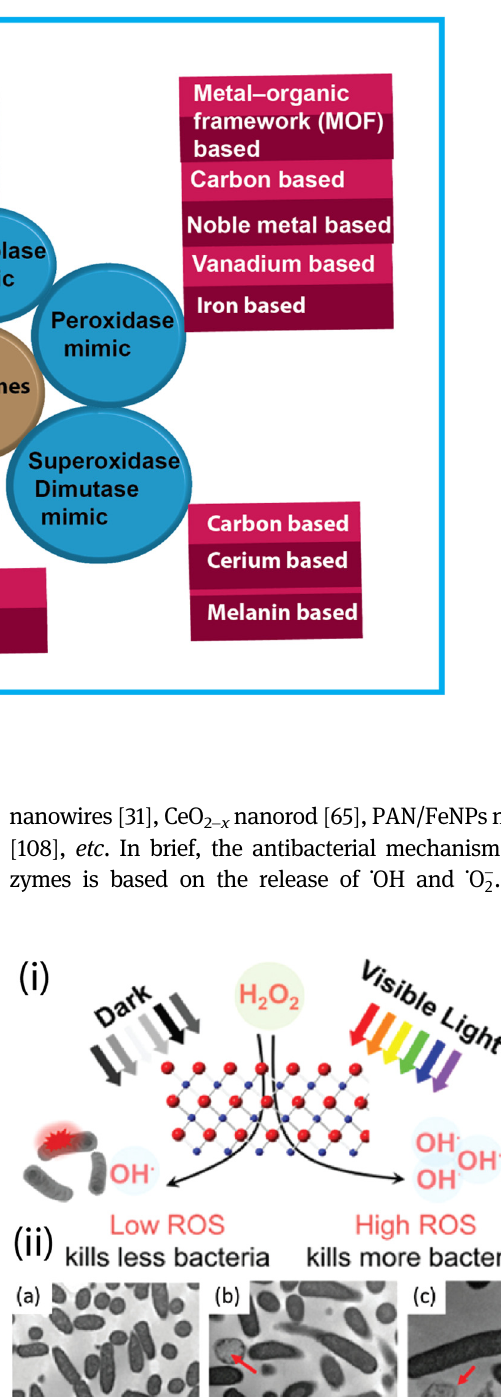
Figure 5: ( i ) Illustration of antibacterial mechanism of nanozyme; ( ii ) transmission electron microscopic images of copper oxide nanorods against E. coli at various treatments: ( a ) control; ( b ) copper oxide nanorods with hydrogen peroxide in the absence of light; and ( c ) copper oxide nanorods with hydrogen peroxide in the presence of light [ 57 ]